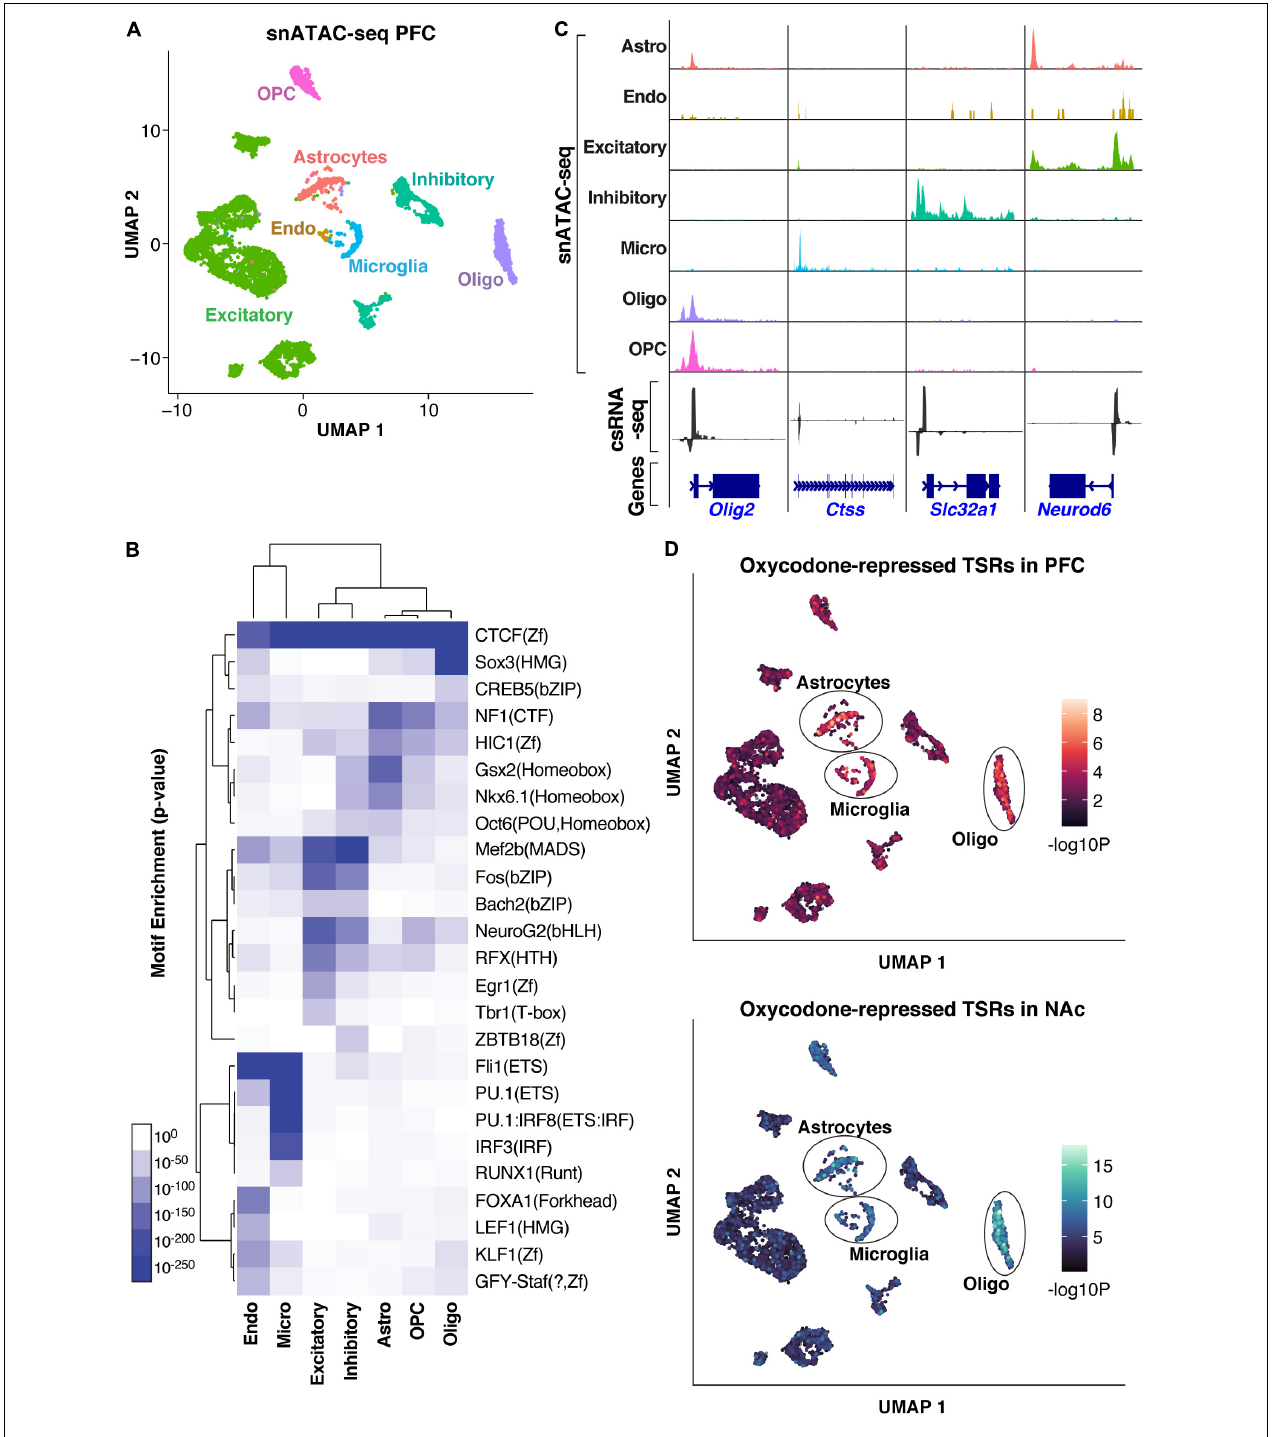
FIGURE 4 | Cell-type assignment of active regulatory elements (TSRs). (A) UMAP clustering of cells based on snATAC-seq of the PFC. Clusters are colored based on cell types inferred from the accessibility patterns near known marker genes. (B) Genome browser tracks of pseudo bulk ATAC-seq read densities showing genes with cell-type-specific snATAC-seq profiles and csRNA-seq from bulk tissue. (C) TF motif enrichment across accessible regions from specific cell types in the snATAC-seq data. (D) UMAP visualization of oxycodone-associated repressed TSRs enriched in individual cells identified by snATAC-seq in PFC and NAc, showing consistent enrichment in astrocyte, microglia, and oligodendrocyte